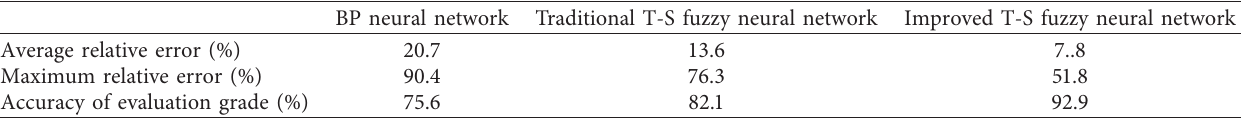
Table 7: Comparison of evaluation results of different neural